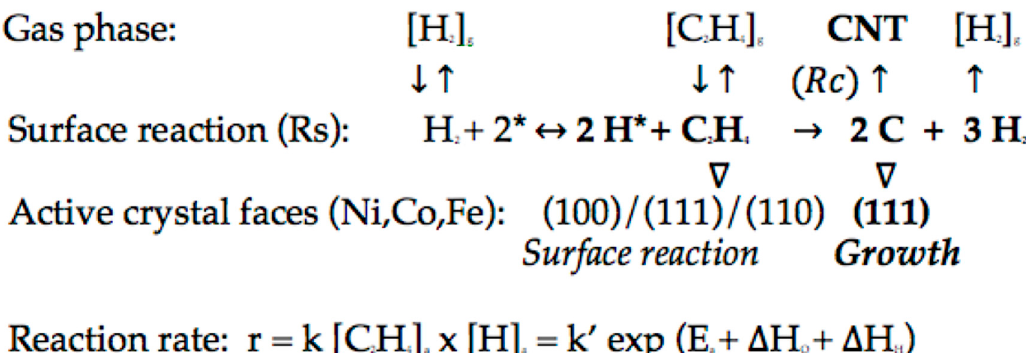
Figure 5. Carbon deposition on nickel foils: Complex temperature dependencies in the range 350–750 °C [6]. Carbon bulk diffusion ( R c ) through the catalyst particles is the rate-controlling step at lower temperatures. Langmuir–Hinshelwood surface reactions ( R s ) are rate-controlling at higher temperatures.